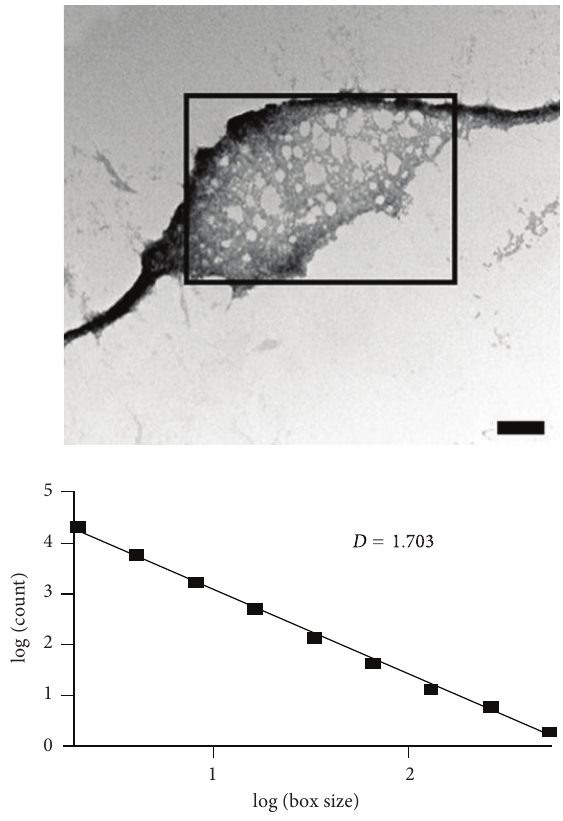
F 8: TEM images of the fractal structures formed by T. aurantia silicatein, initially depolymerized from spicules at pH 9 and then allowed to reassemble at low temperature. e fractal dimension of 1.7, obtained by counting the number of �lled squares within boxes of increasing size, indicates formation of an elaborate self-assembly network by simple Brownian motion. Reproduced with permission from